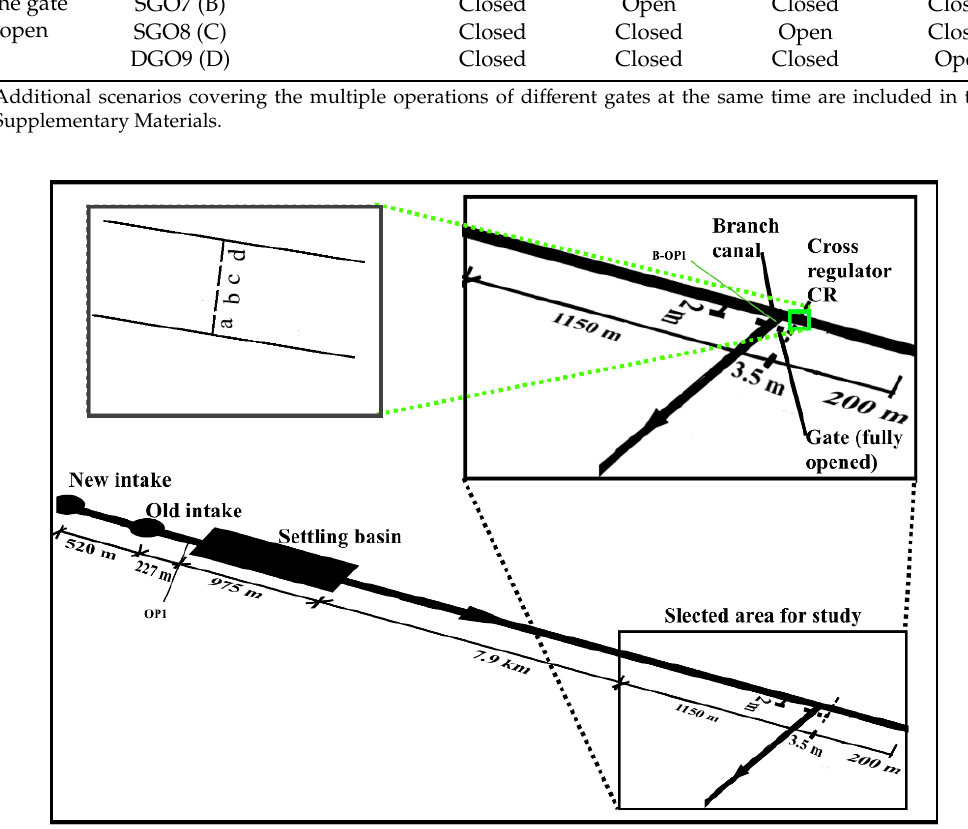
Figure 7. The location of Gates in the Canals in the model ( left ) and as seen in Google Earth ( right ).